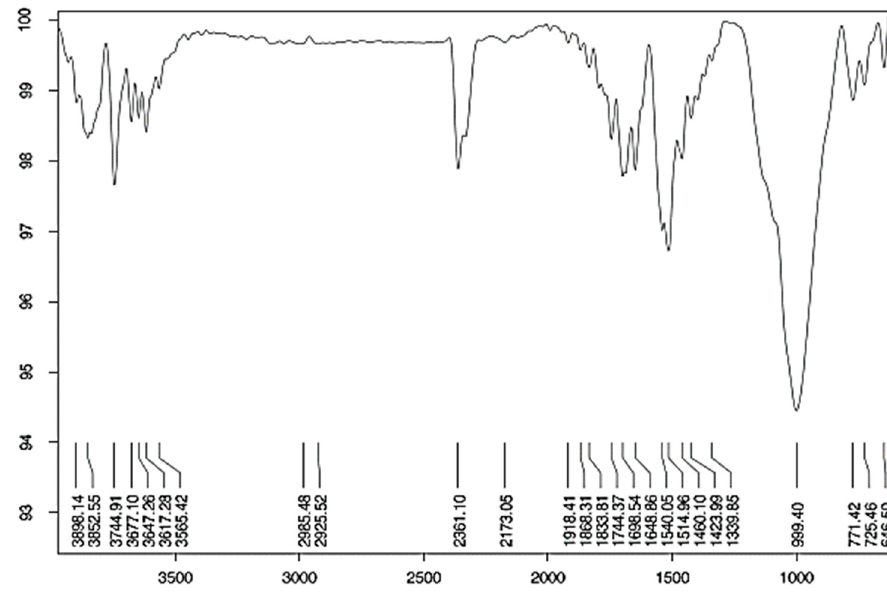
Figure 22. Fourier transform infrared spectroscopy (FTIR) of geopolymer concrete [102].